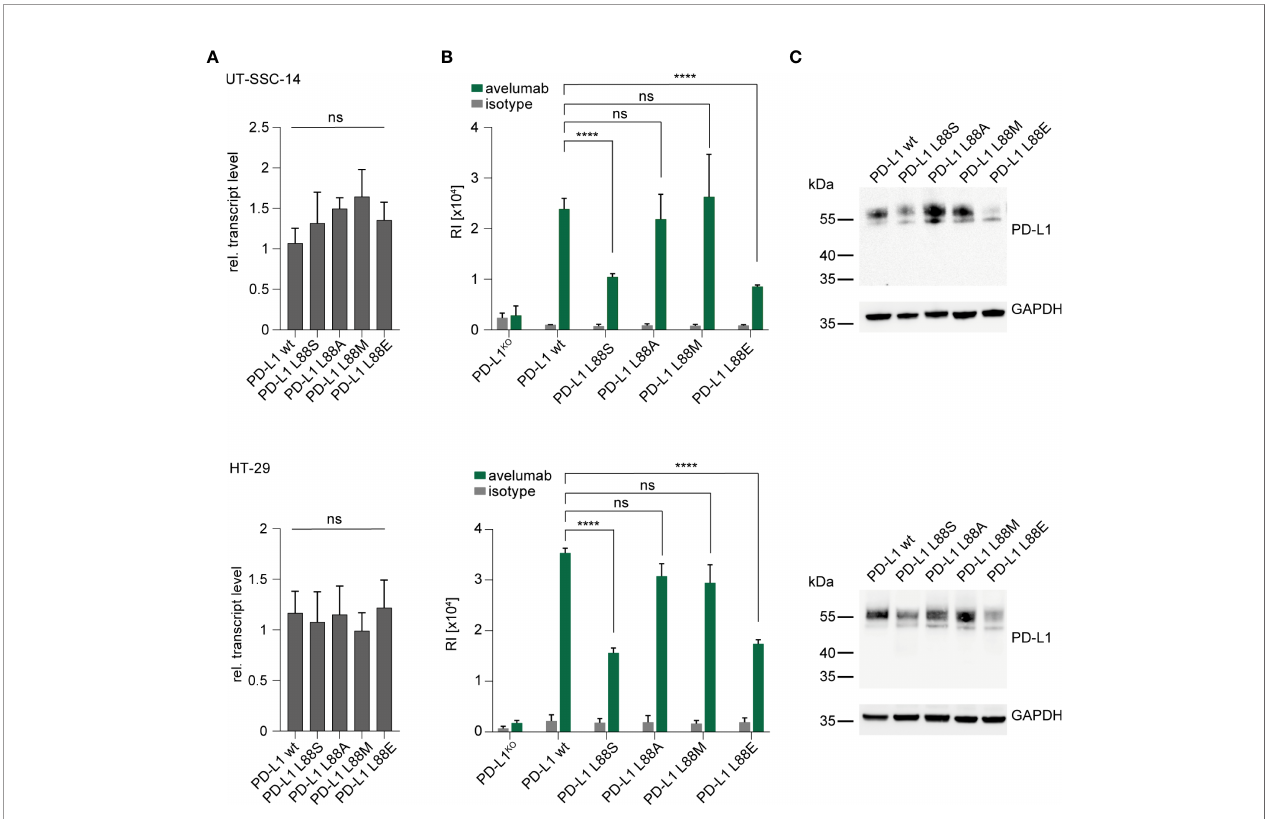
FIGURE 2 | Introduction of new PD-L1 variants into PD-L1-de fi cient tumor cells. ( A – C ) UT-SSC-14 and HT-29 cells ectopically expressing PD-L1 L88S, L88A, L88M, and L88E were analyzed by (A) qRT-PCR (replicates n = 4), (B) fl ow cytometry (replicates n = 4-6), and (C) Western blotting in comparison with PD-L1 wt. Data are presented as mean ± SD. RI, relative mean fl uorescence intensity. Statistics: Welch ’ s ANOVA over all groups (A) with post-hoc Dunnett ’ s test (B) . Asterisks indicate p -value range (* p < 0.05; ** p < 0.01; *** p < 0.001; **** p < 0.0001; ns >